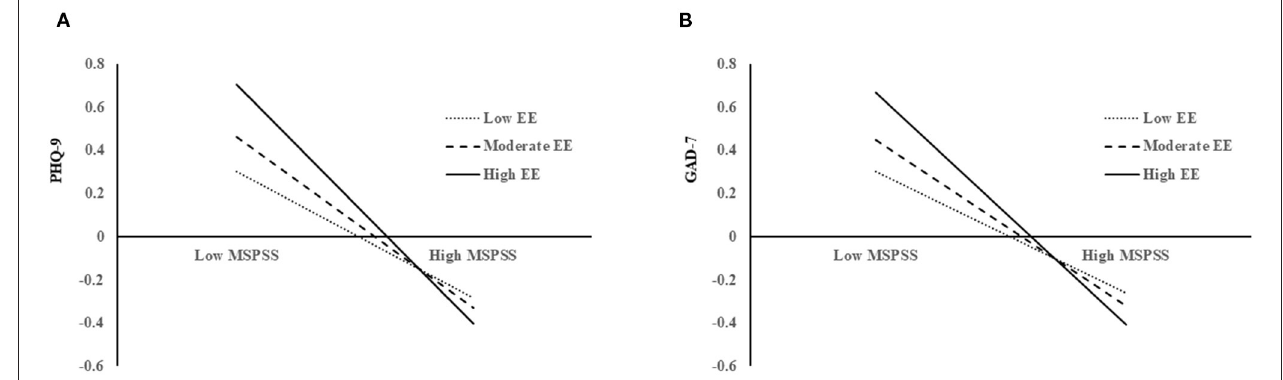
FIGURE 1 | Simple slope analyses. (A) The interaction between perceived social support and depression as moderated by earthquake exposure and shows that perceived social support was negatively associated with depression better with higher earthquake exposure. (B) The interaction between perceived social support and anxiety as moderated by earthquake exposure and shows that perceived social support was negatively associated with anxiety better with higher earthquake exposure. MSPSS, Multidimensional Scale of Perceived Social Support; EE, earthquake exposure; PHQ-9, Patient Health Questionnaire; GAD-7, Generalized Anxiety Disorder